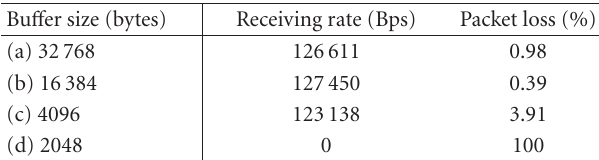
Table 1: Receiving rate and packet loss for di ff erent bu ff er